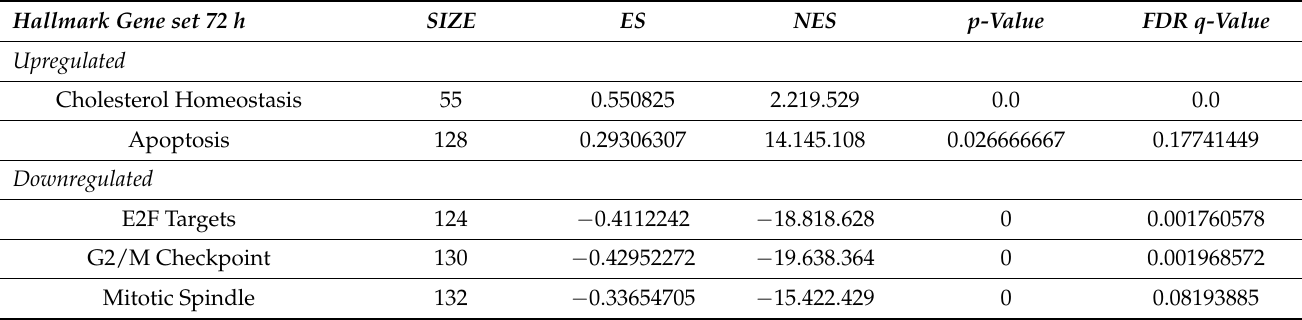
Table 2. Gene sets enriched in CENP-E transient knocked-down IMR90